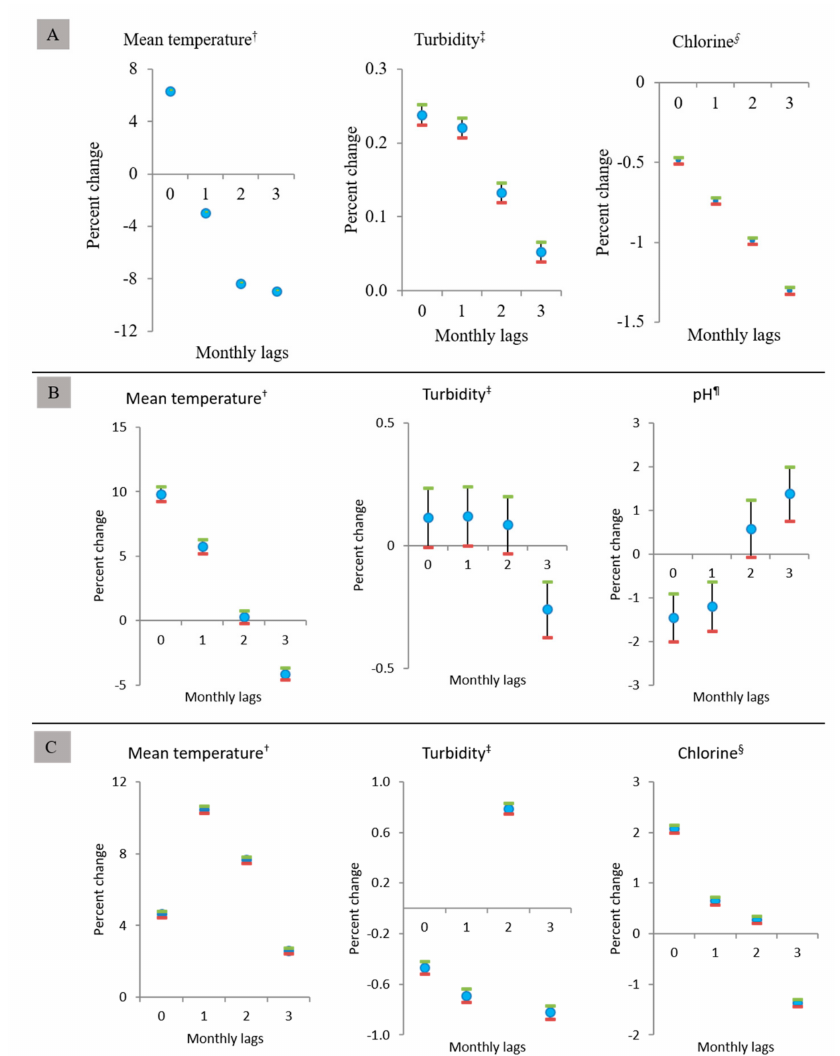
Figure 3. Poisson regression model showing associations between environmental variables and the monthly number of ( A ) HFMD, ( B ) AM, and ( C ) AHC cases from 2010 to 2015 in seven metropolitan provinces of Korea. † Monthly average of mean temperature ( ◦ C); ‡ monthly average of turbidity (NTU), § monthly average of residual chlorine (mg/L) and ‡ monthly average pH (mg/L). HFMD: hand-foot-mouth disease, AM: aseptic meningitis, AHC: acute hemorrhagic